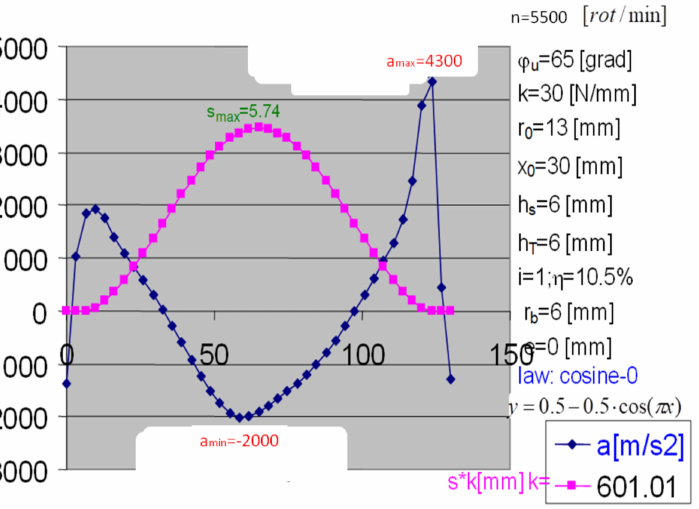
Figure 14. Dynamic analysis at module B. COSINE law, n = 5500 [rot/min] ϕ u = 65 [degree], r 0 = 13 [mm], r b = 6 [mm], h T = 6